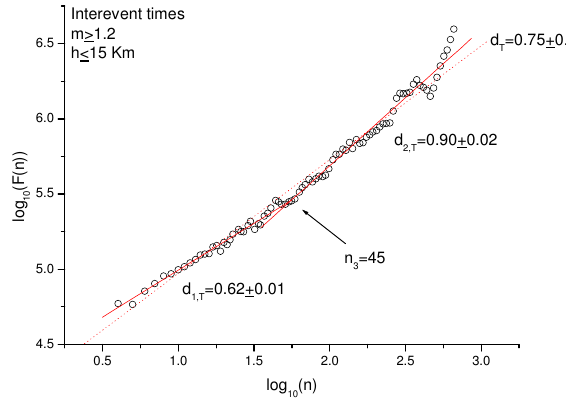
Fig. 4. DFA results for the interevent time series shown in Fig. 6.